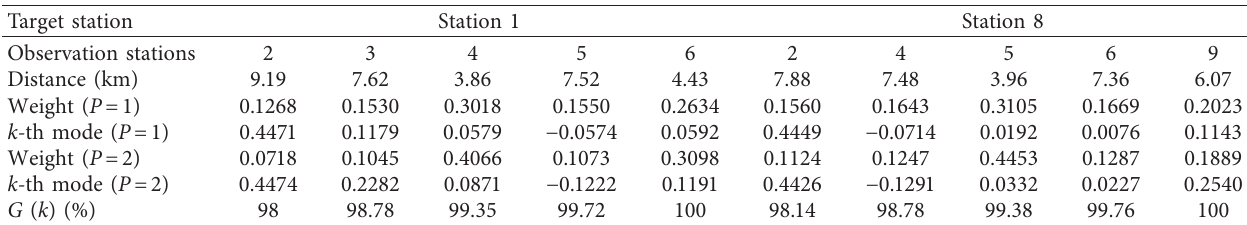
Table 2: Distances from station 1 and 8 to other five observation stations and corresponding normalized inverse distance weights when power P � 1 and 2, respectively.